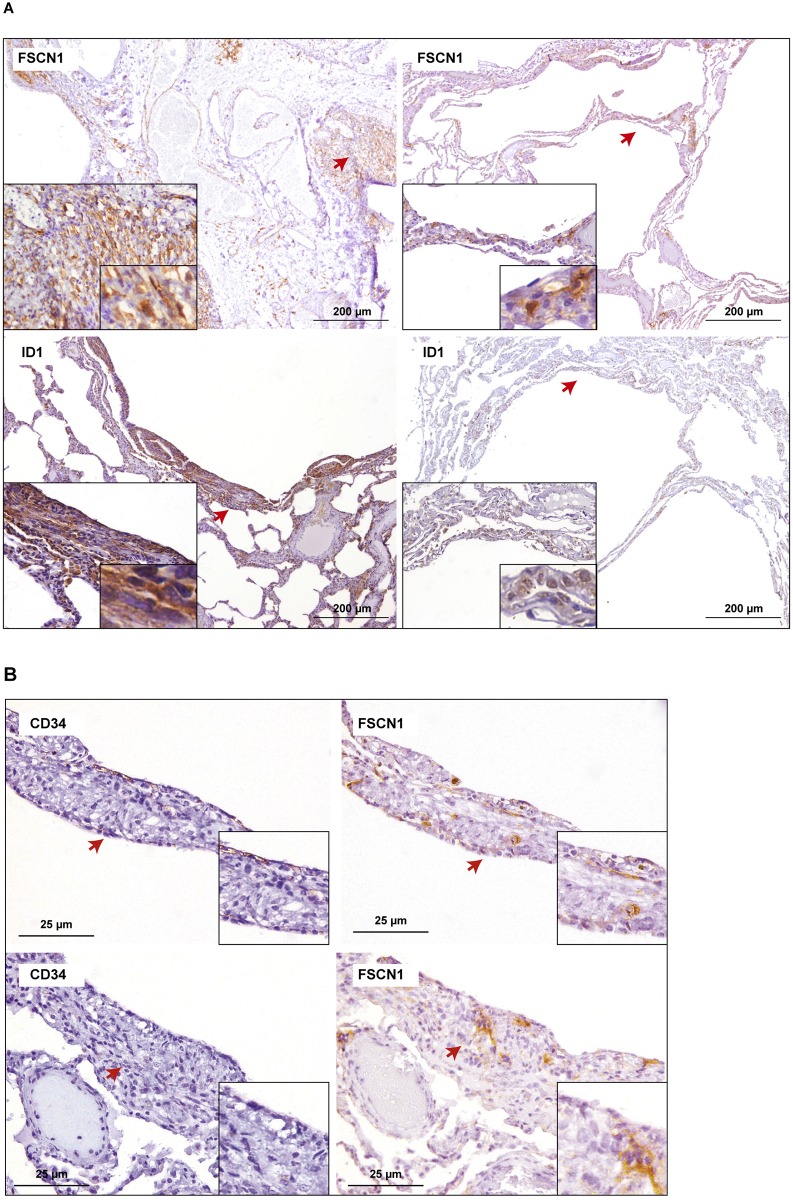
Positivity for breast cancer lung metastasis mediators in LAM tissue.(A) Representative results for FSCN1 and ID1 in two LAM cases. Arrows mark magnified fields shown in the insets. (B) Representative immunohistochemistry results for CD34 and FSCN1 in LAM tissue. Positivity for FSCN1 is greater and not limited to endothelial cells.